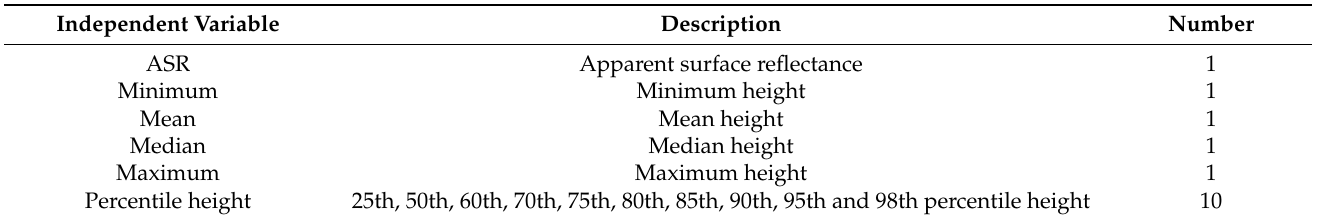
Table 2. Height metrics and apparent surface reflectance extracted from ATL08 used in the study. Independent Variable